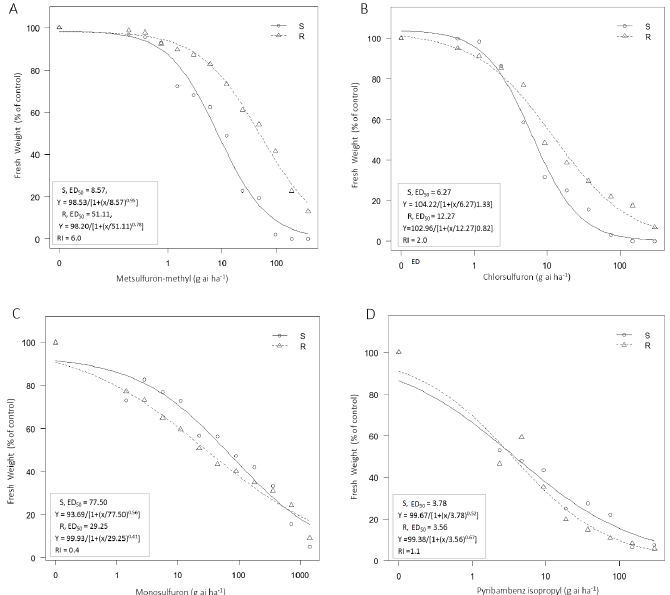
Figure 1. Sensitivities of the S and R P. fugax biotypes to different ALS herbicides. ( A ) metsulfuron-methyl; ( B ) chlorsulfuron; ( C ) monosulfuron; ( D ) pyribambenz isopropyl. ED 50 : herbicide dose to inhibit growth by 50%; RI: resistance index.